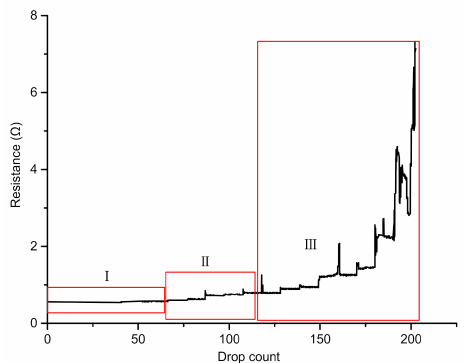
Figure 5. Typical resistance curves of daisy chains under drop test.